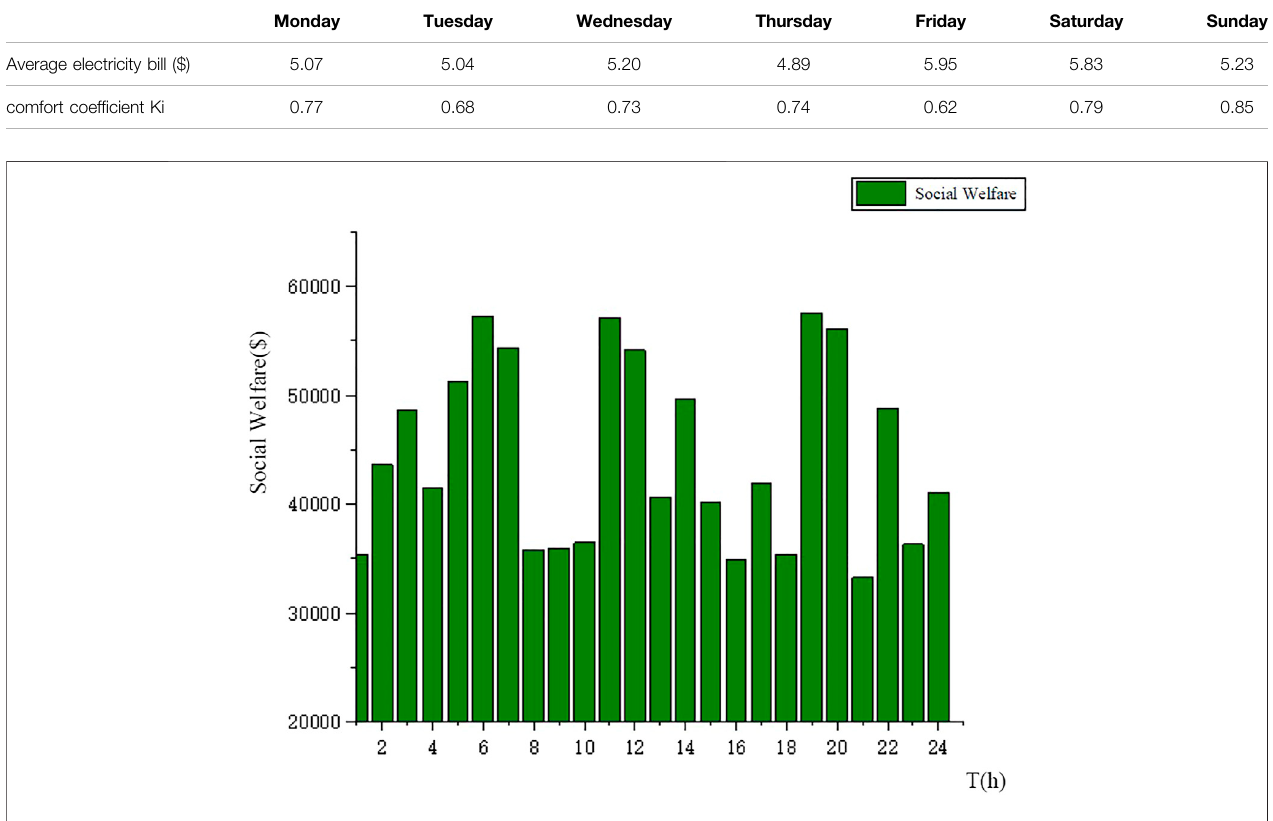
FIGURE 8 | The social welfare representation diagram of the day in scene 1.